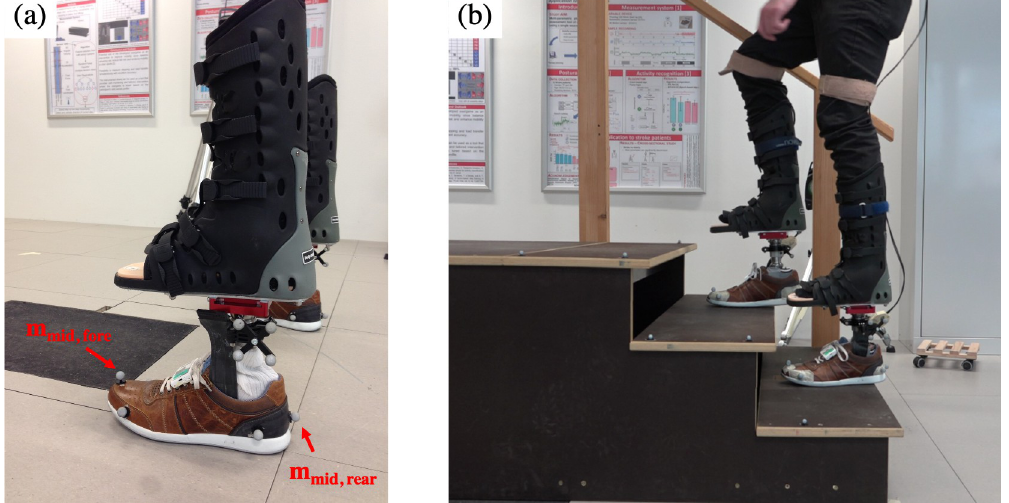
Fig 2. Sensor configuration and protocol environment. (a) the prosthetic system composed of the foot fixed under the orthotic boot. (b) The prosthetic system as worn by the participants during stair climbing.